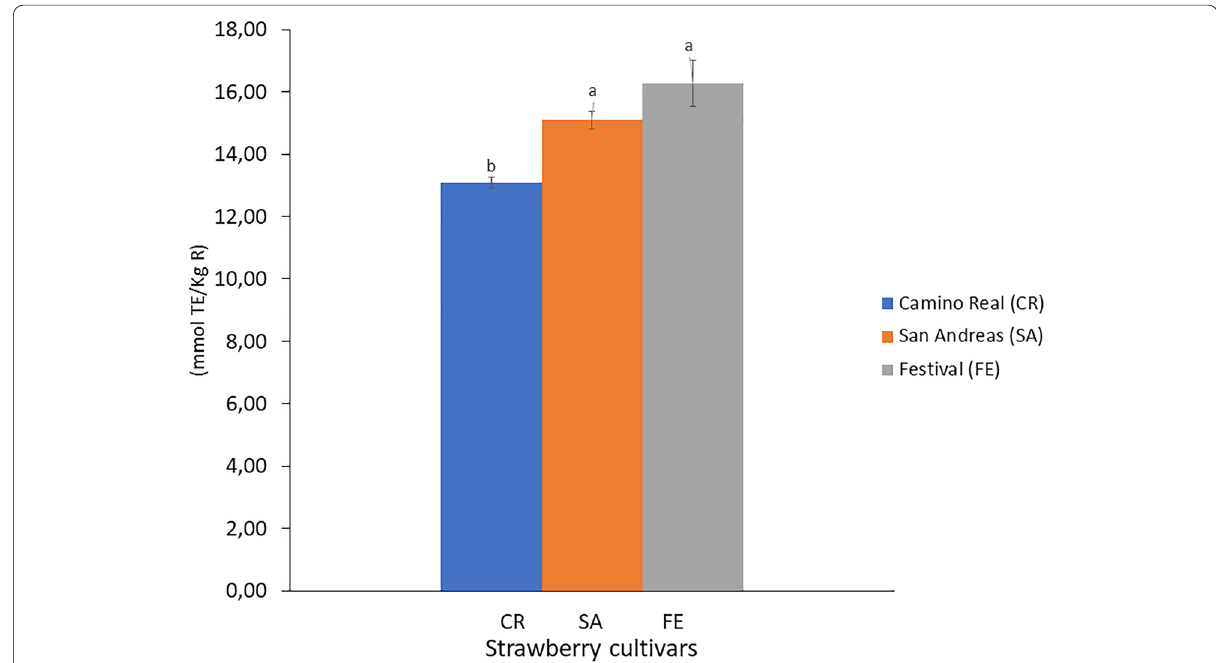
Fig. 2 Antioxidant capacity of the by‑products of three strawberry cultivars. Different letters indicate significant differences ( p < 0.05) among cultivars by Tukey’s test